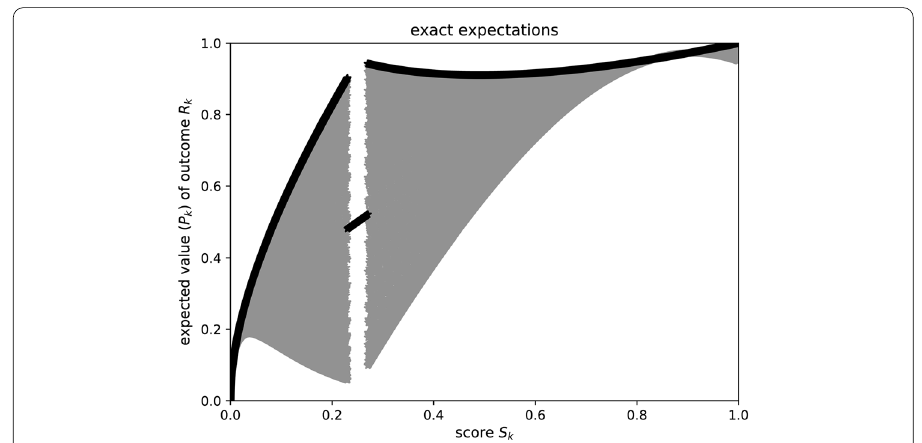
Fig. 2 Ground-truth reliability diagram for Fig.